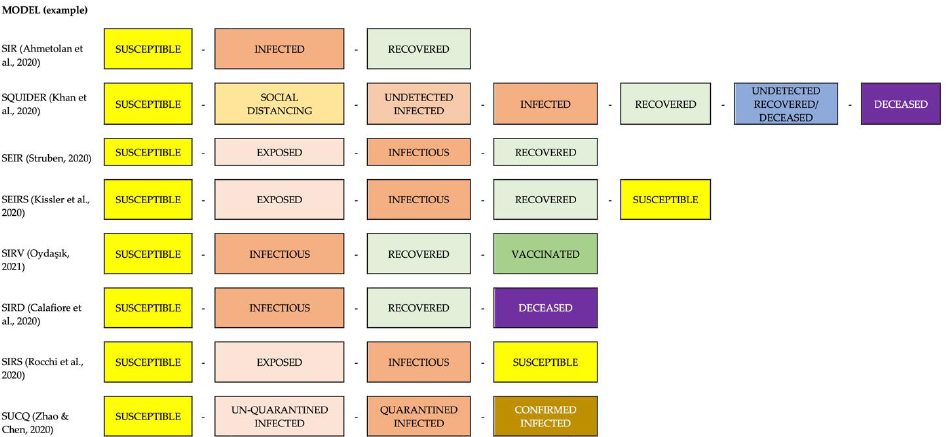
Figure 1. Flow diagram for the literature search and study selection.